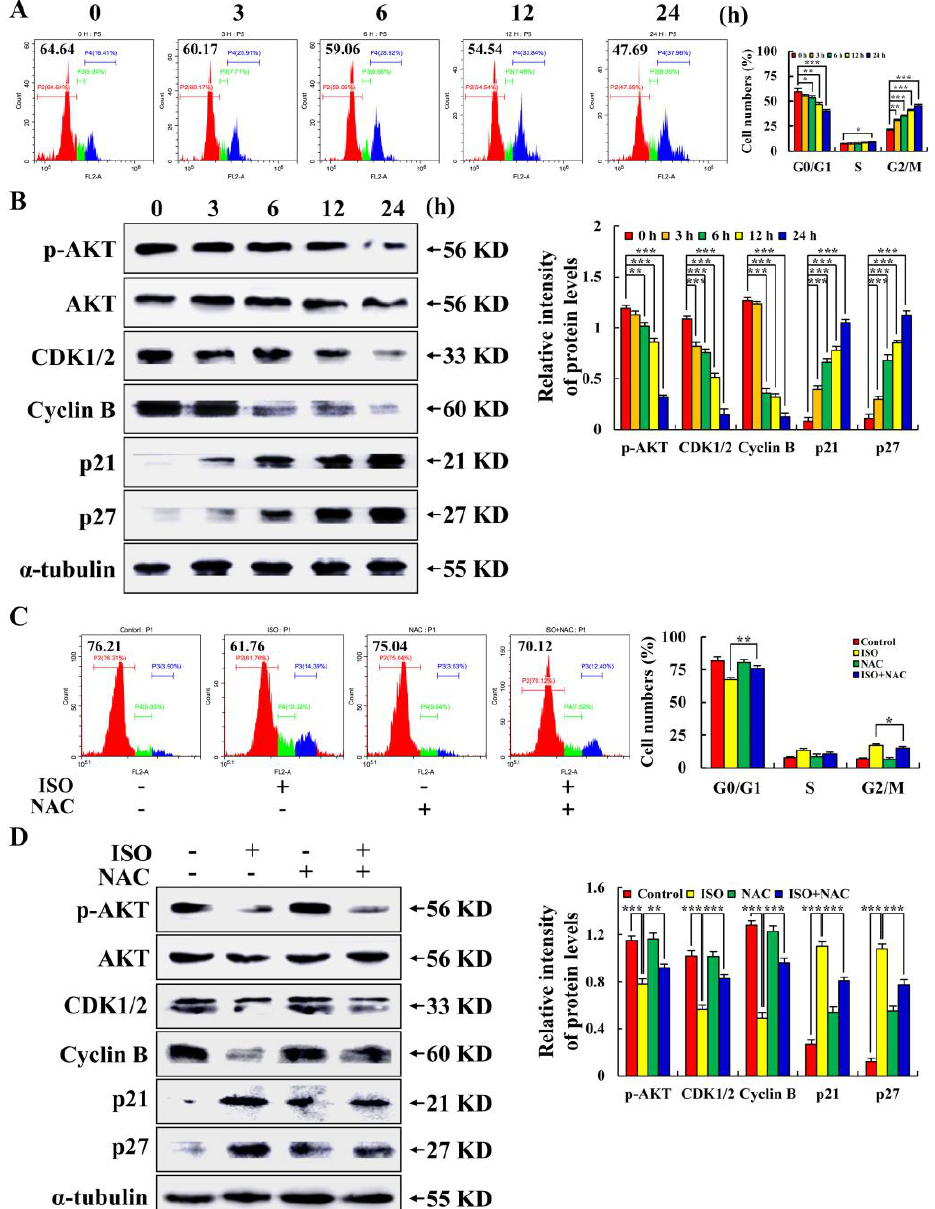
Figure 5. The arresting effects of ISO on the cell cycle in AGS cells. A total of 36.54 µ M ISO was applied to AGS cells from 0 to 24 h. ( A ) Percentage of cell cycle number of AGS cells. ( B ) Expression of proteins involved in the G2/M cell cycle. ( C ) Percentage of cell cycle number of AGS cells treated with ISO (36.54 µ M) and/or NAC (10 mM). ( D ) Expression of proteins involved in the G2/M cell cycle of AGS cells treated with ISO (36.54 µ M) and/or NAC (10 mM), and α –tubulin was used as an internal reference protein. * p < 0.05, ** p < 0.01 and *** p < 0.001 vs. 0 h or NAC +